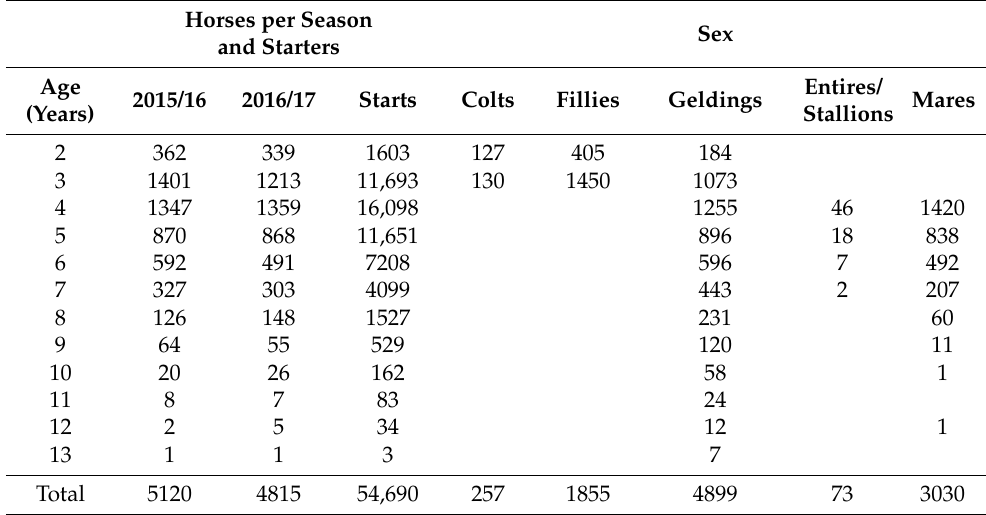
Sex Entires/ Stallions